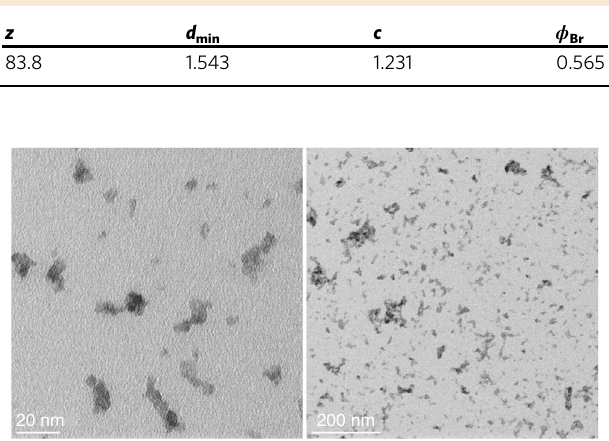
Fig. 5 TEM images with different magni fi cation of tungsten blue oxide aggregates. TEM samples were taken in parallel to the SAXS measurements. The primary particles have a mean diameter of about 5 – 6 nm. From the second image (lower magni fi cation) it is plausible that the aggregates consist in average of about 84 primary particles and have an average size of about 62